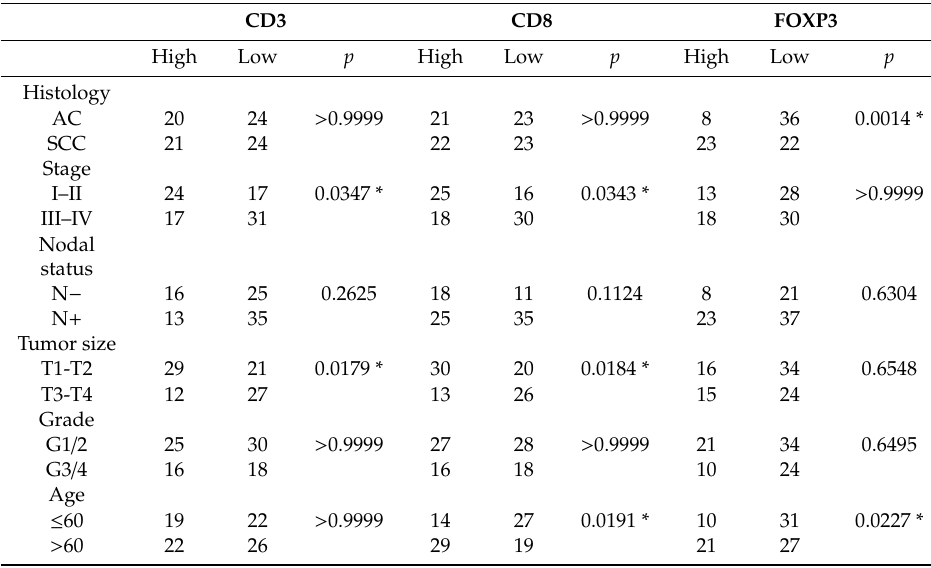
Table 3. Clinicopathological characteristics and T-cell markers in